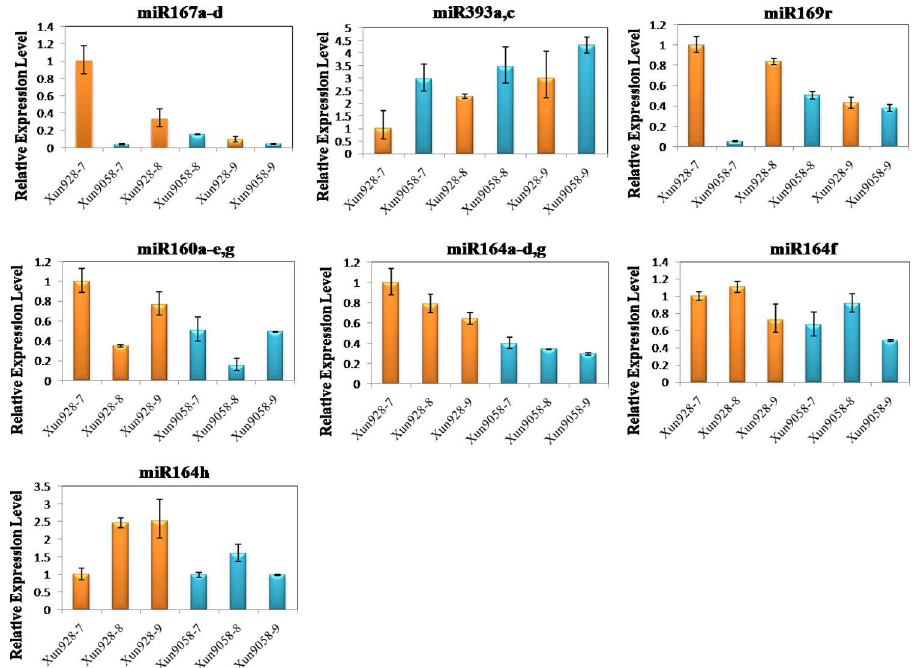
Fig 3. Expression levels of maize internode-associated miRNAs as determined by RT-PCR. 18S rRNA was used as the reference gene. Three biologicalreplicates and three technical replicateswere performed. Data represent the mean values ± SD of three